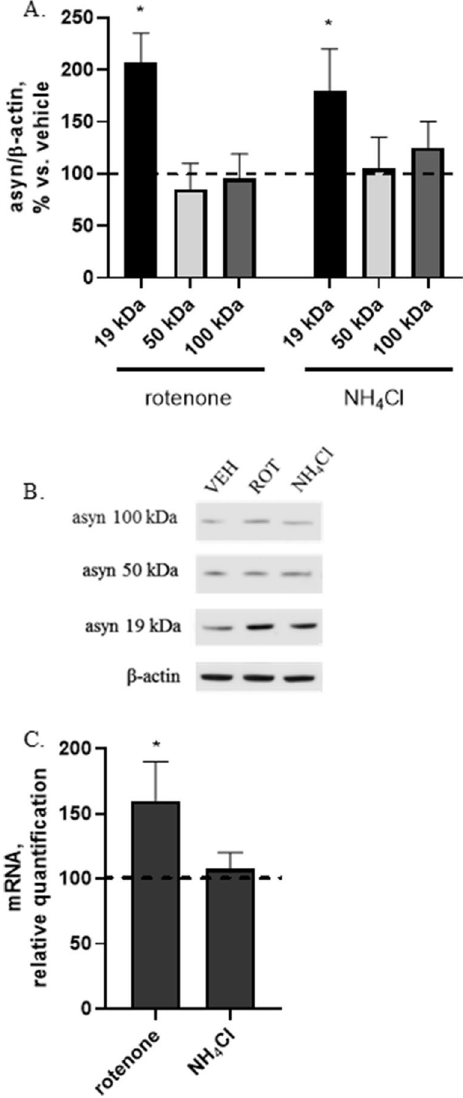
Figure 4. Effect of rotenone (400 nM, 24 h) or NH 4 Cl (10 mM, 24 h) on protein expression of monomeric (19 kDa) and oligomeric/aggregated (50 and 100 kDa) asyn forms ( A ) and asyn gene expression ( C ). Increased monomeric asyn was found in rotenone- or NH 4 Cl-treated cells ( A , B ) and increased asyn gene transcription was found in rotenone-treated cells ( C ). ( B ) Representative Western blot image showing immunoreactivity for monomeric (19 kDa) and oligomeric/aggregated (50 and 100 kDa) asyn forms and β-actin, used as internal standard, in vehicle-treated cells (VEH) and cells exposed to rotenone (400 nM, 24 h) or NH 4 Cl (10 mM, 24 h). Full-length blot is presented in Supplementary M&M. (N = 3; *p < 0.05 vs.